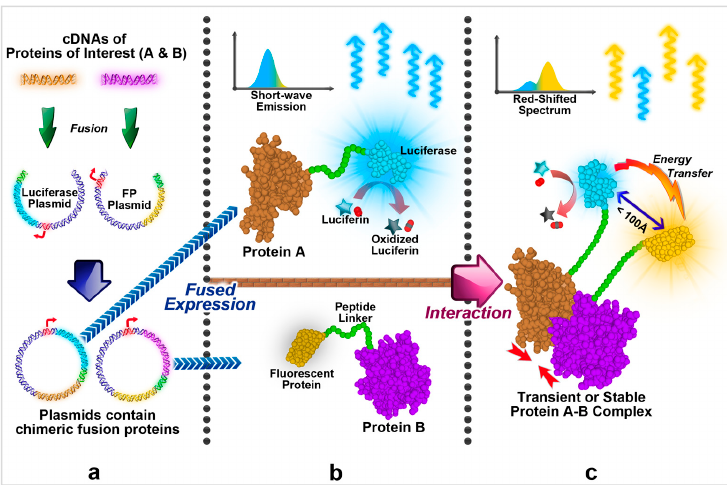
Figure 1. Principles of BRET assay. Arrows show the oversimplified procedure of using BRET to detect the interaction between two proteins: ( a ) The cDNAs of proteins of interest (Protein A and B) are separately fused with genes of luciferase and fluorescent protein, and co-expressed as tagged chimeric proteins; ( b ) luciferase oxidizes luciferin, giving off high-frequency light, while the fluorescent protein remains inactive; ( c ) interactions between Protein A and Protein B bring luciferase and fluorescent protein to close proximity, then fluorescent protein draws energy from luciferase and generates lower frequency light, causing the easily observable frequency shift in